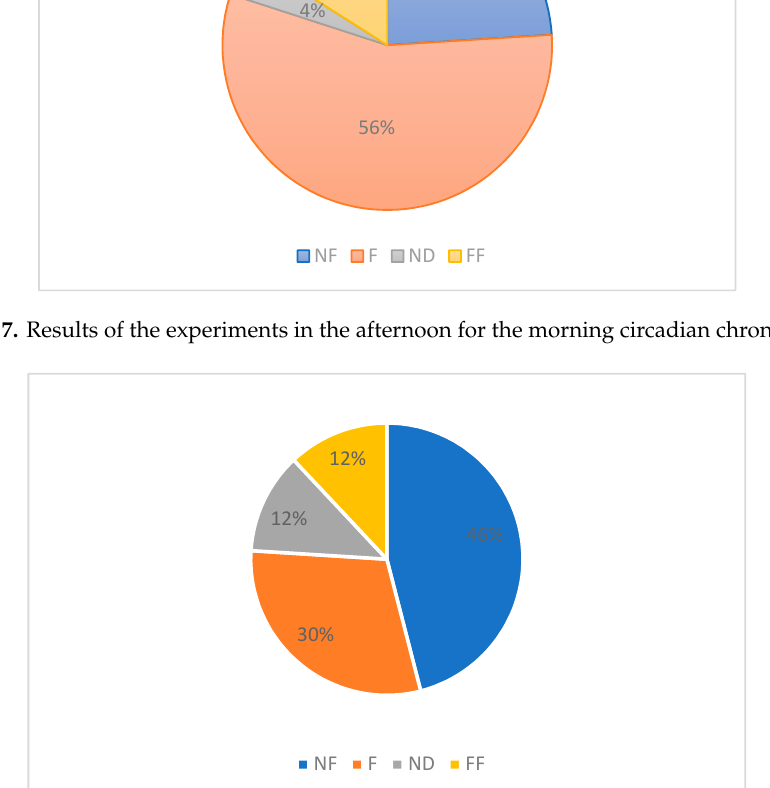
Figure 8. Results of the experiments in the morning for the evening circadian chrono-type.